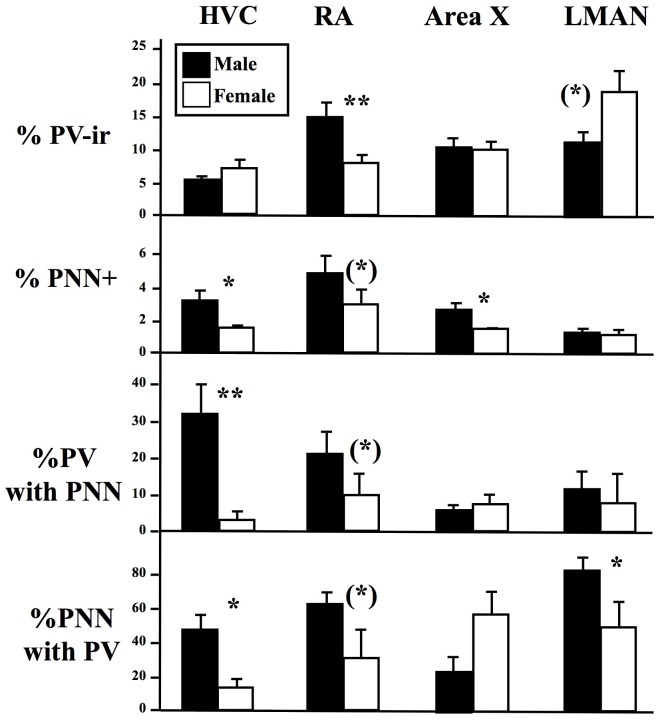
Sex differences in the percentage of DAPI cells that were immunoreactive for parvalbumin (%PV-ir cells) or were surrounded by perineuronal nets (%PNN cells), in the percentage of PV-ir cells surrounded by PNN (%PV with PNN) and in the percentage of PNN surrounding PV-ir cells (%PNN with PV) in 4 song control nuclei, HVC (used as a proper name), RA (robust nucleus of the arcopallium), Area X of the basal ganglia and LMAN (lateral magnocellular nucleus of the anterior nidopallium).The figure shows the mean ± SEM of data in males (black bars) and females (open bars). Numbers of data in each case are listed in Table 1. ** = p<0.01, * = p<0.05 and (*) = 0.10<p<0.05.